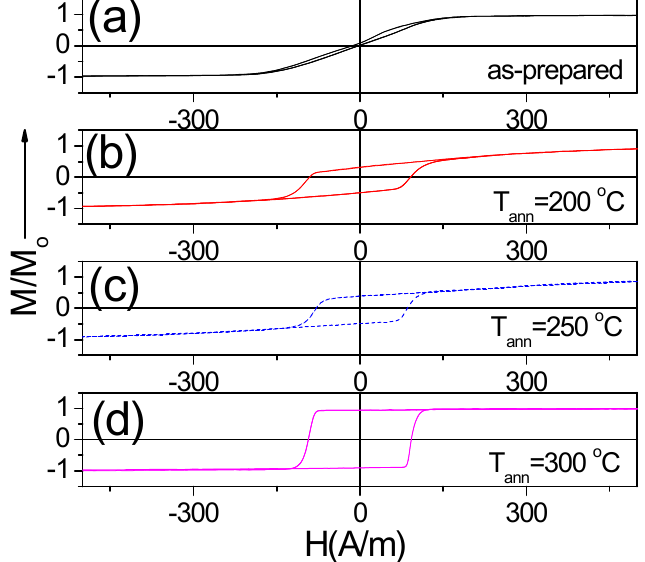
Figure 5. Hysteresis loops of as-prepared ( a ) and annealed at 200 °C ( b ), 250 °C ( c ) and 300 °C ( d ) Fe 3.6 Co 69.2 Ni 1 B 12.5 Si 11 Mo 1.5 C 1 microwires.